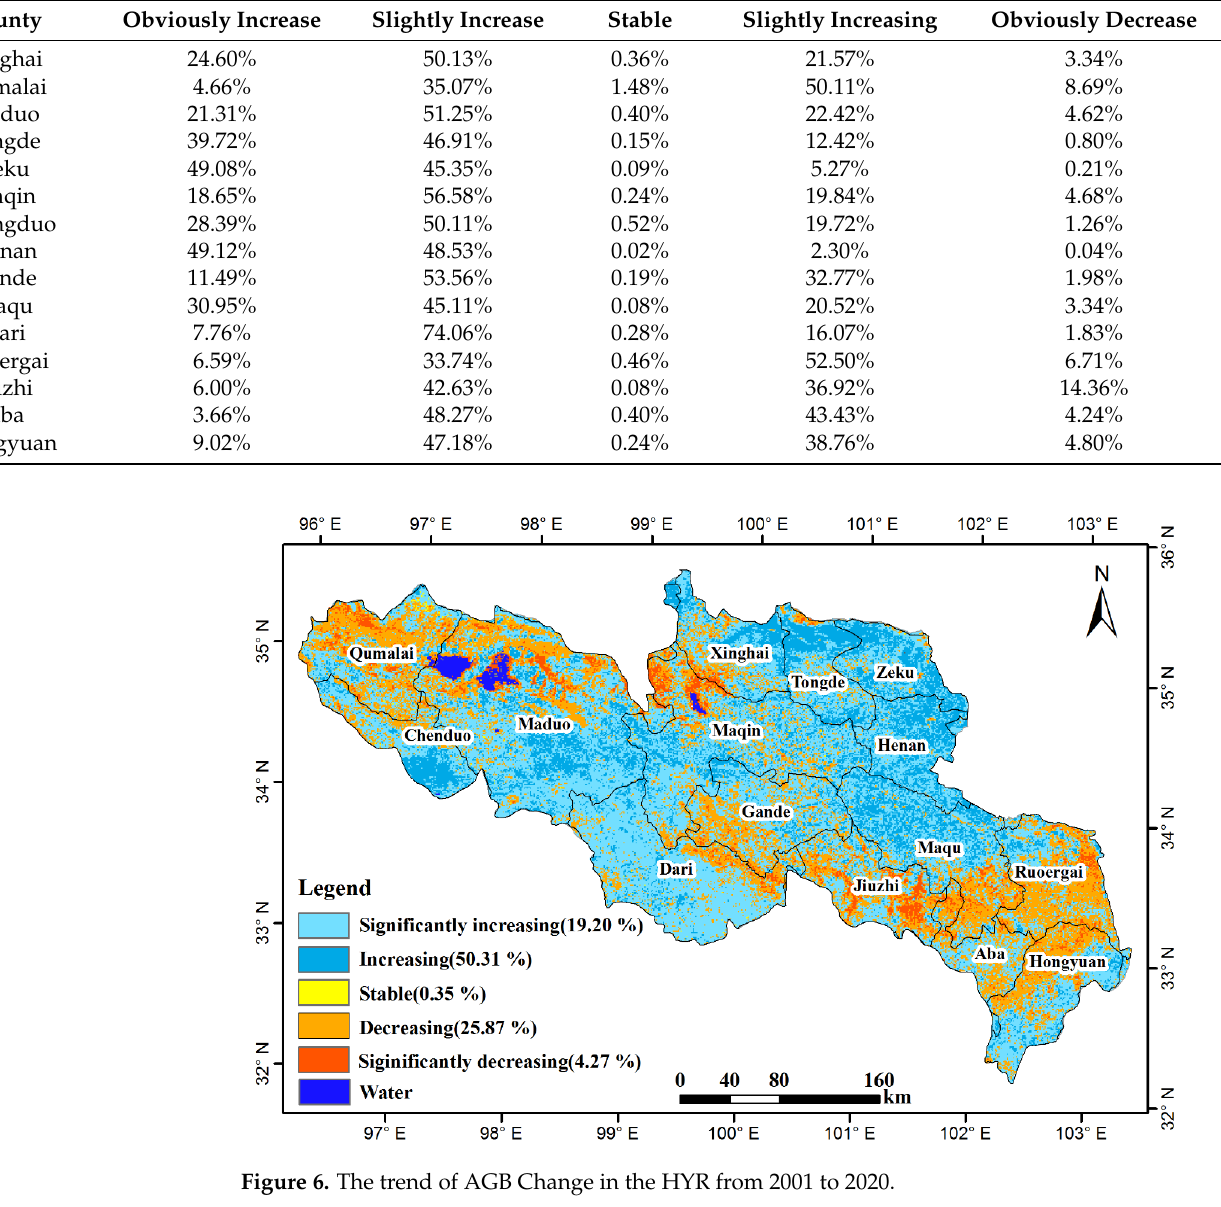
Figure 6. The trend of AGB Change in the HYR from 2001 to 2020.